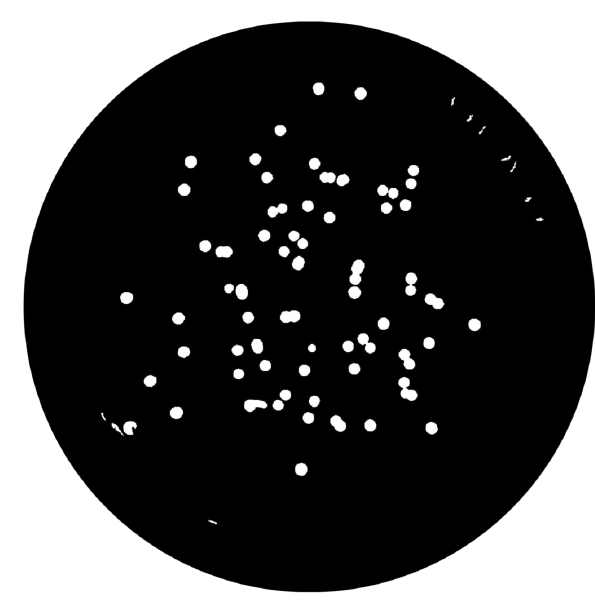
Figure 12. Detected round